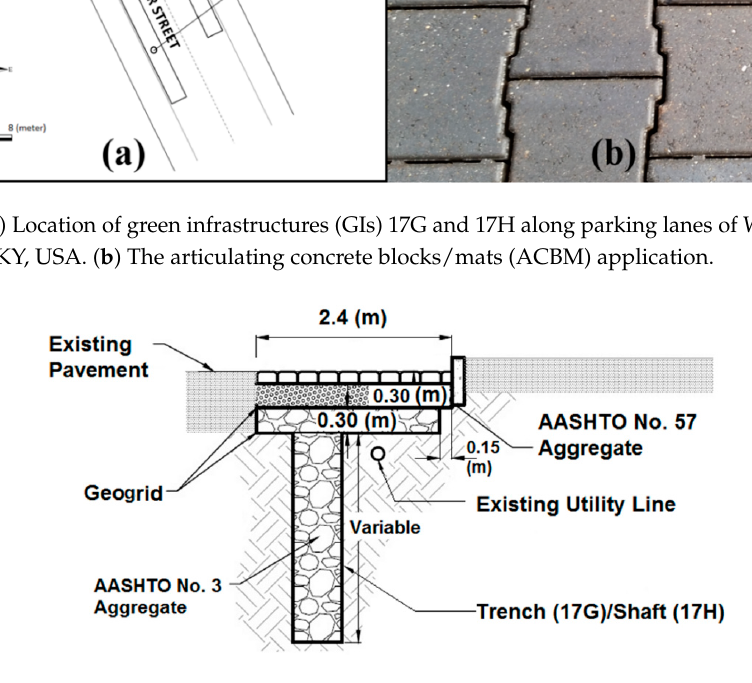
Figure 2. Cross-sectional view of the permeable pavement systems 17G and 17H. AASHTO: American Association of State Highway and Transportation. Table 1. Design and drainage characteristics of monitored permeable pavement systems. Green